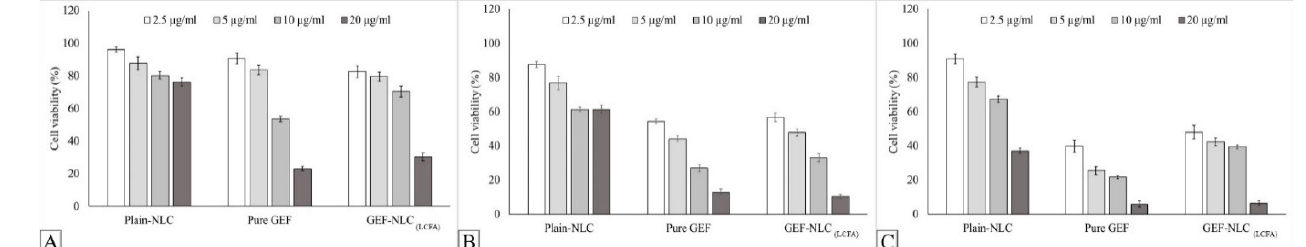
Figure 10. ( A ) Particle size and PDI and ( B ) zeta potential values of GEF-NLC (LCFA) and GEF- NLC (LCT) . Data are expressed as the mean ± SD, N = 3.